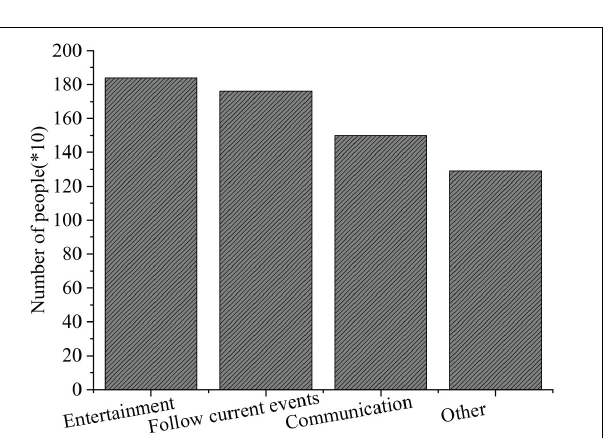
FIGURE 8 | Questionnaire Survey of purposes for using new media.